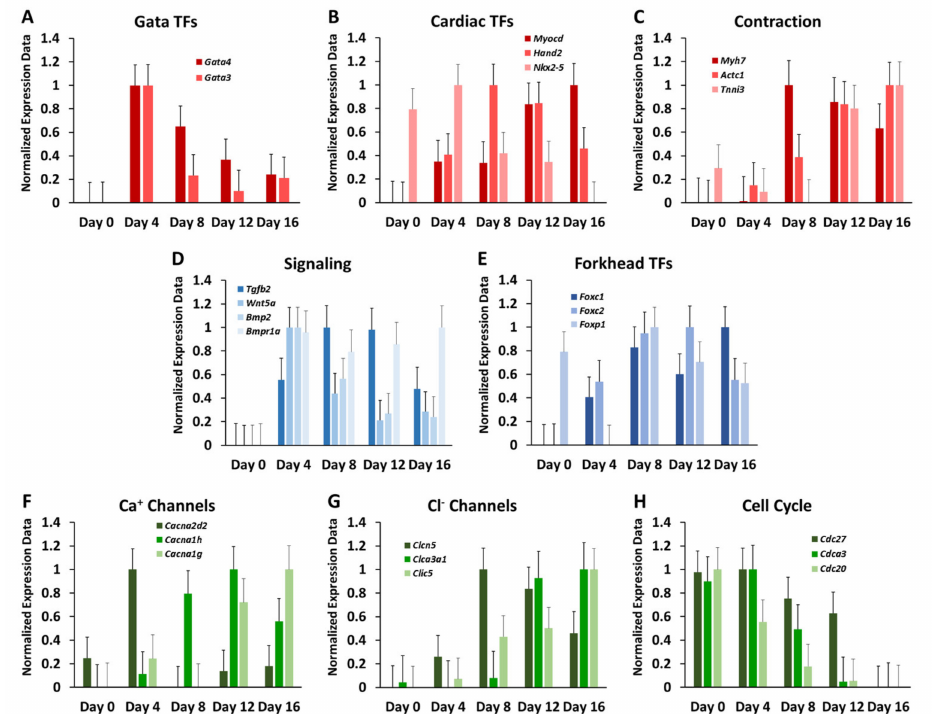
Figure 5. Temporal expression profiles of genes associated with heart development and ion channel function. Expression values were transformed to the [0, 1] range. The scale included a larger range to capture the errors intervals. In the graphics are shown: ( A ) GATA transcription factors (TFs); ( B ) other known key TFs for cardiogenesis; ( C ) genes encoding for structural cardiac proteins; ( D ) signalling pathway molecules linked for cardiac development; ( E ) forkhead gene family; ( F ) calcium channel genes; ( G ) chloride channel genes; ( H ) cell cycle genes. Standard error bars are